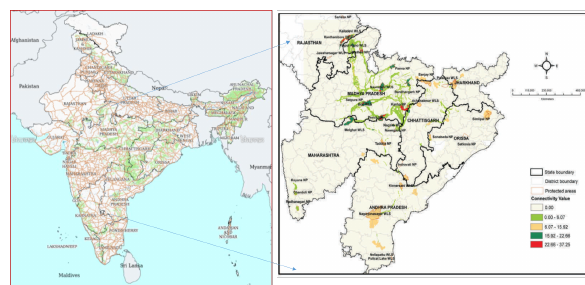
Figure 2: Study Area